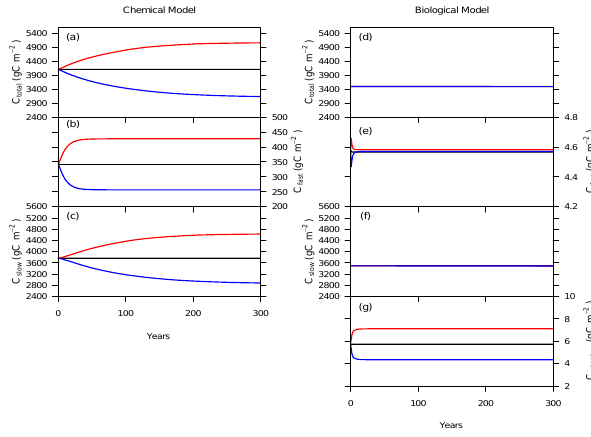
300240028003200360040004400480052005600 ) m − 2 g C w ( C s l o Figure 3. Soil carbon stocks of the chemical and biological mod- els for the litter quantity experiments. (a) is the total soil carbon ( C total , gCm − 2 ), (b) fast pool ( C fast , gCm − 2 ), (c) slow pool ( C slow , gCm − 2 ) of the chemical model, (d) is the total soil car- bon ( C total , gCm − 2 ), (e) fast pool ( C fast , gCm − 2 ), (f) slow pool ( C slow , gCm − 2 ) and (g) microbial biomass ( C microbes , gCm − 2 ) of the biological model. Black line shows the nominal run, red line the increased litter and blue the decrease litter scenario. Only the first 300 years of the simulation are